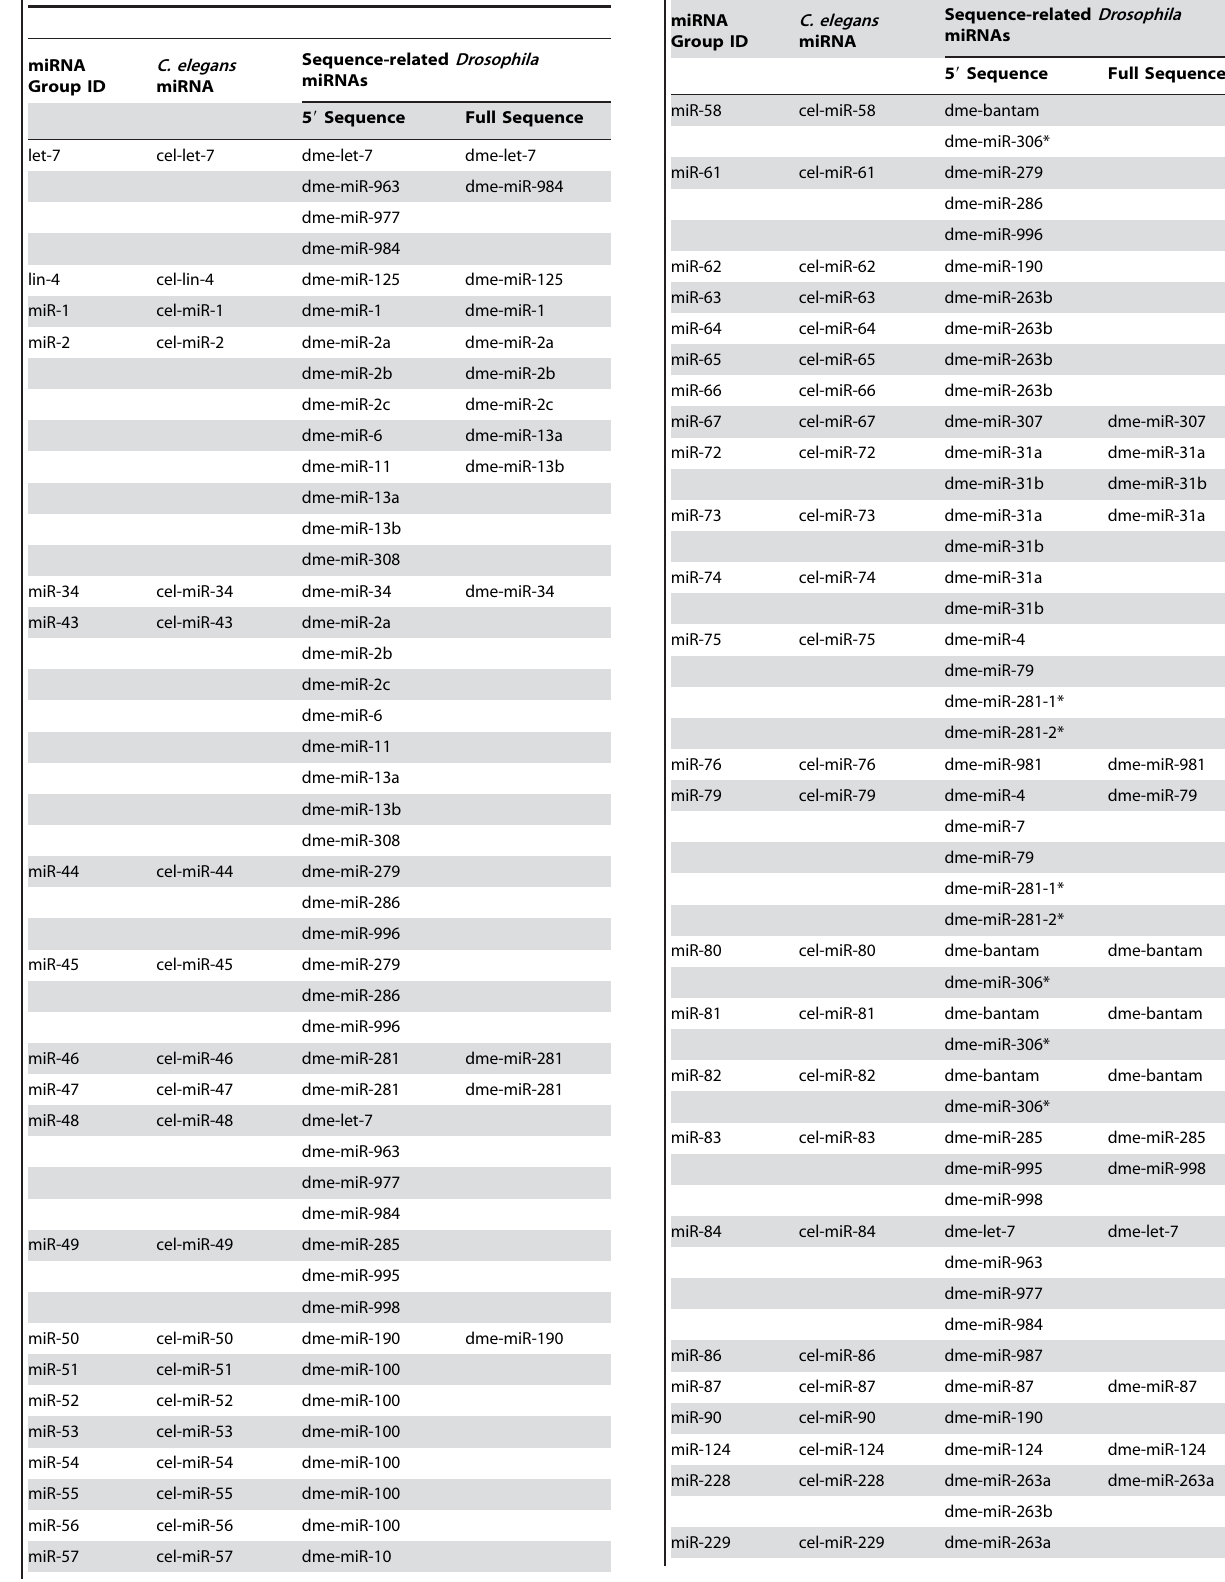
Table 3. Combined searches for 5 9 and $ 70% full sequence similarities detect 87 miRNA families containing 87 C. elegans miRNAs and 65 D. melanogaster